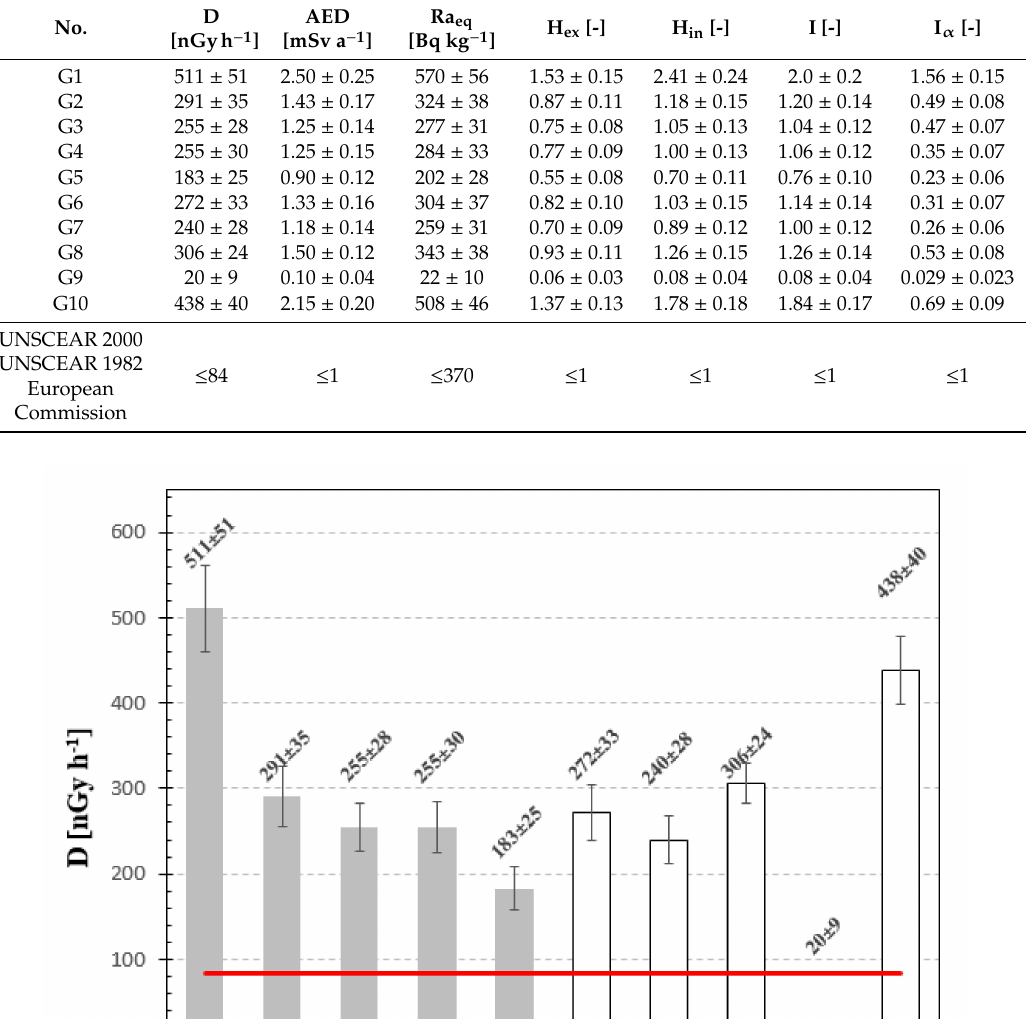
Table 3. Absorbed gamma dose rate, annual e ff ective dose rate, radium equivalent activity, external and internal hazard indices, gamma index and alpha index. Values and calculated uncertainties are presented.